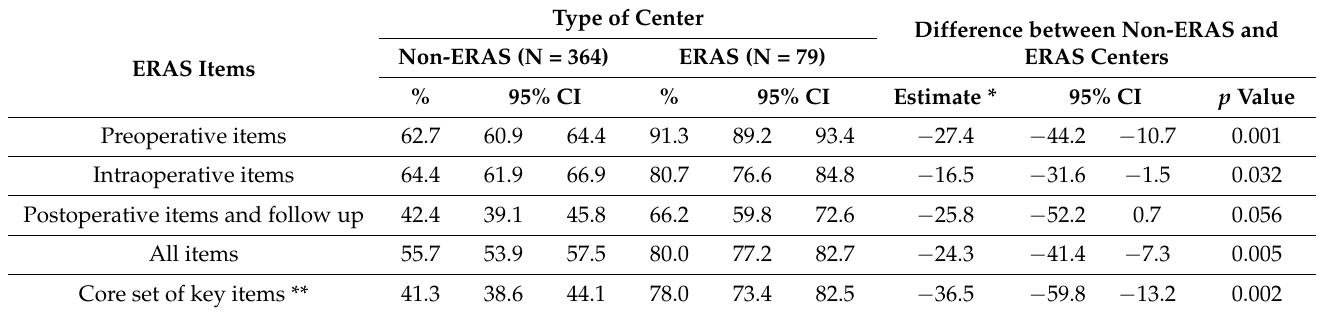
Table 2. Level of compliance (%) to groups of ERAS items by type of center (non-ERAS and ERAS).